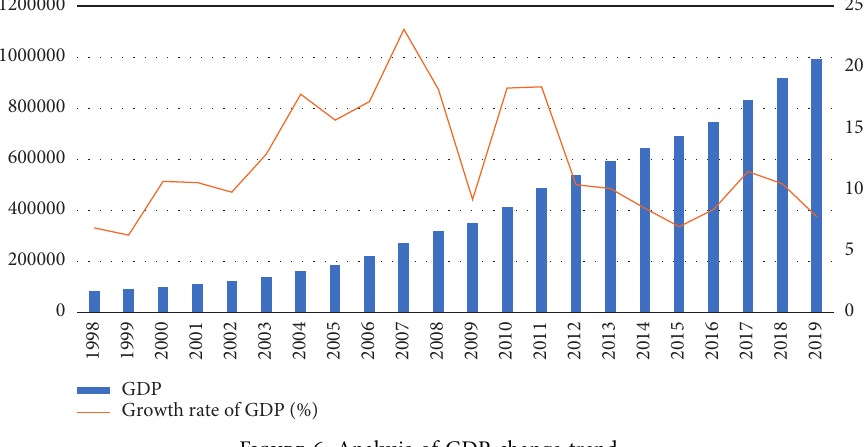
Figure 6: Analysis of GDP change